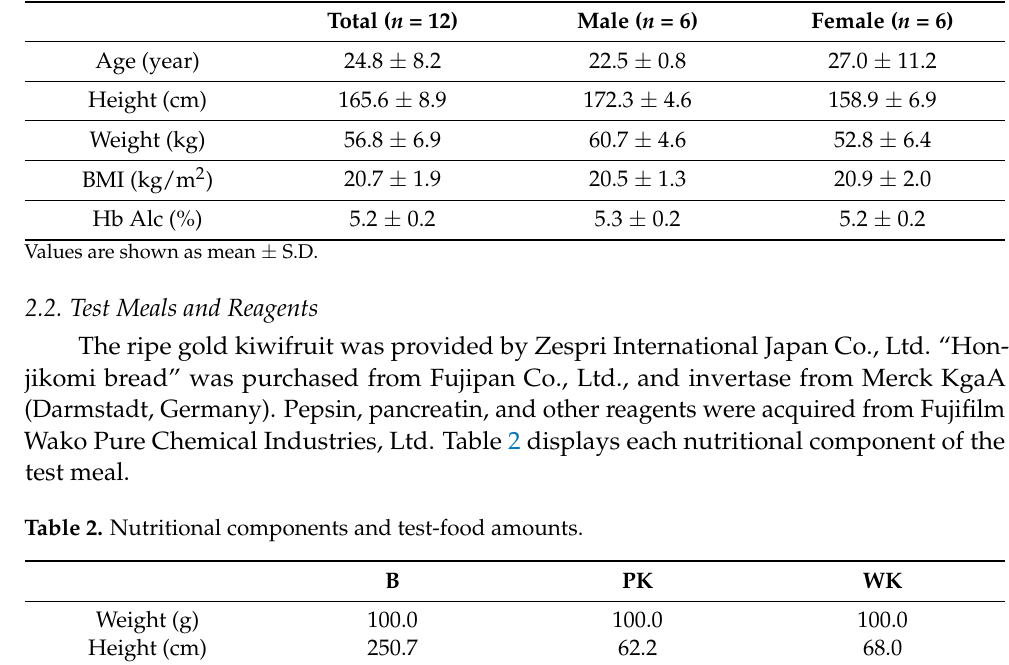
Table 1. Subject characteristics.